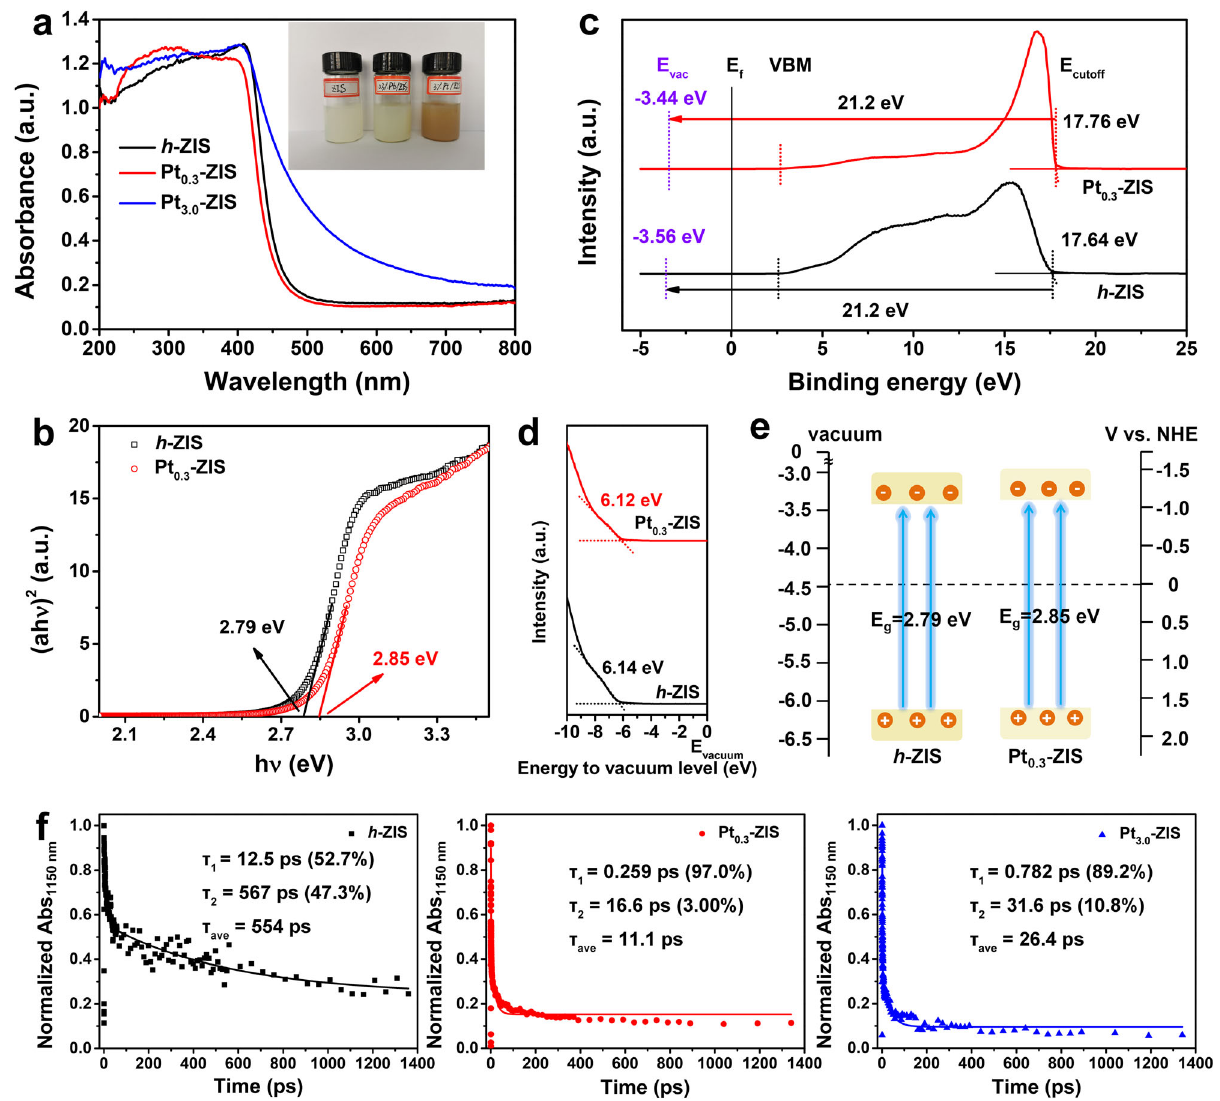
Fig. 4 Mechanism insight the photocatalytic H 2 evolution. a UV – vis diffuse re fl ectance spectra for h -ZIS, Pt 0.3 -ZIS, and Pt 3.0 -ZIS, insert: digital images for h -ZIS, Pt 0.3 -ZIS, and Pt 3.0 -ZIS, the concentration of suspensions is 2 mg mL and E vac of UPS spectra. d UPS spectra of h -ZIS and Pt 0.3 -ZIS in the valence band region. e Schematic illustration of the band structure of h -ZIS and Pt 0.3 - ZIS. f Normalized time pro fi les of transient absorption at 1150 nm during the TDR of h -ZIS, Pt 0.3 -ZIS, and Pt 3.0